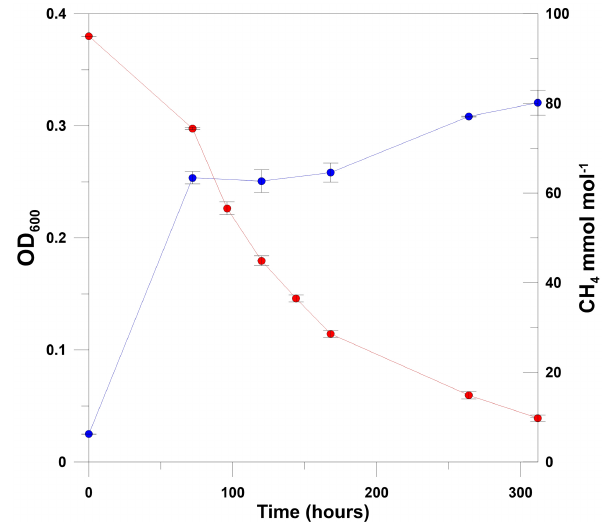
Figure 4. Growth (blue line) and corresponding variation of the methane in the headspace of the serum bottles as a result of methane consumption (red line) of the Pan1 Methylocystis sp. strain. The av- erages of the optical density measures (OD 600 ) ± standard error are from three replicate 160mL serum bottles incubated at 37 ◦ C at pH 5.8. No decrease in headspace methane was observed in uninocu- lated controls (data not